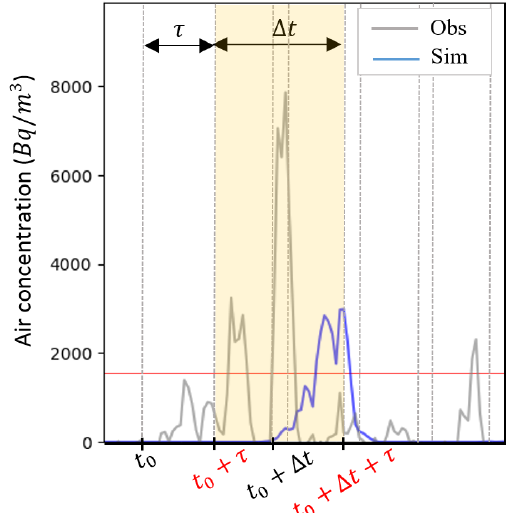
Figure 13. Illustration of the temporal discretization method by sliding intervals used in this study. This figure shows the case of the second time interval of length (cid:49)t : ( t 0 + τ,t 0 + (cid:49)t + τ ). – TN: when there is no observed peak but simulated by a number of members less than x